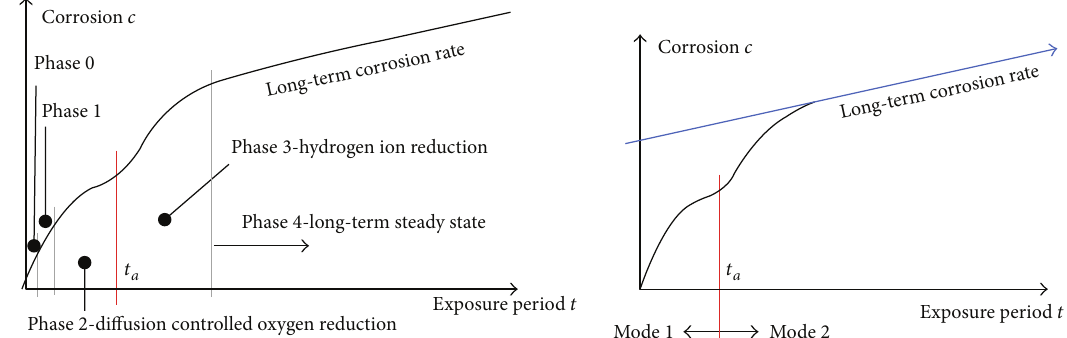
Figure 1: Schematic bimodal model for long-term corrosion loss and pit depth in marine environments showing brief descriptions for each of the phases involved and the linear idealization for long-term corrosion. The change from mode 1 with predominantly oxic corrosion conditions to mode 2 with predominantly anoxic conditions occurs at 𝑡 𝑎 .